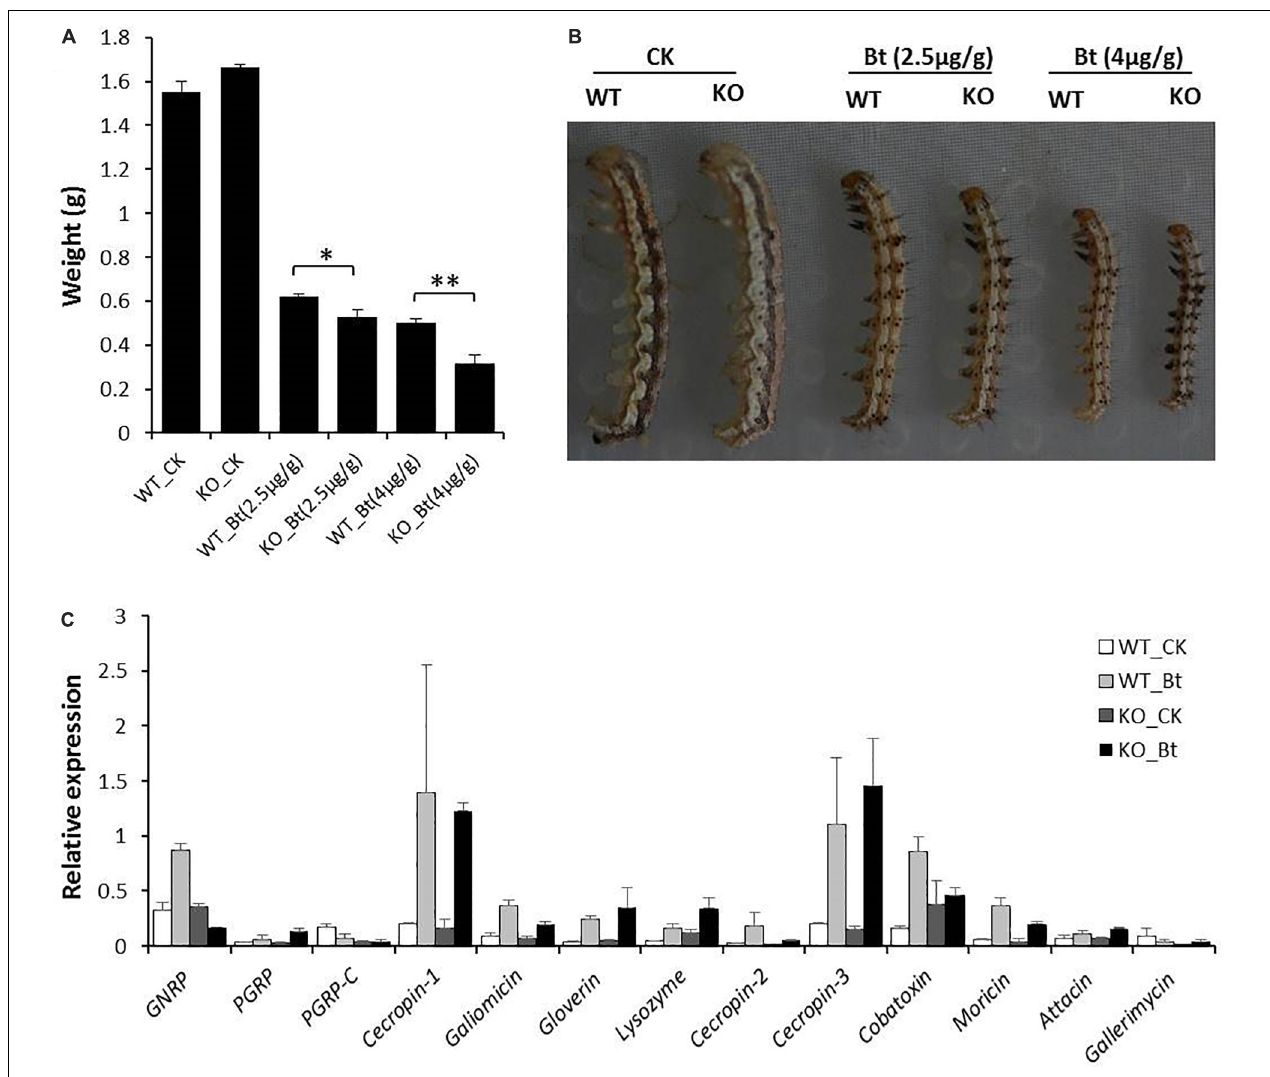
FIGURE 4 | Sensitivity of KO and WT cotton bollworm to Bt toxins. (A,B) Growth and development of KO and WT cotton bollworm after feeding with an artificial diet containing Cry1Ac. (C) Expression levels of immune-related genes in KO and WT after feeding with Cry1Ac. Data are mean SD, n = 3. ∗ P < 0.05; ∗∗ P < 0.01.